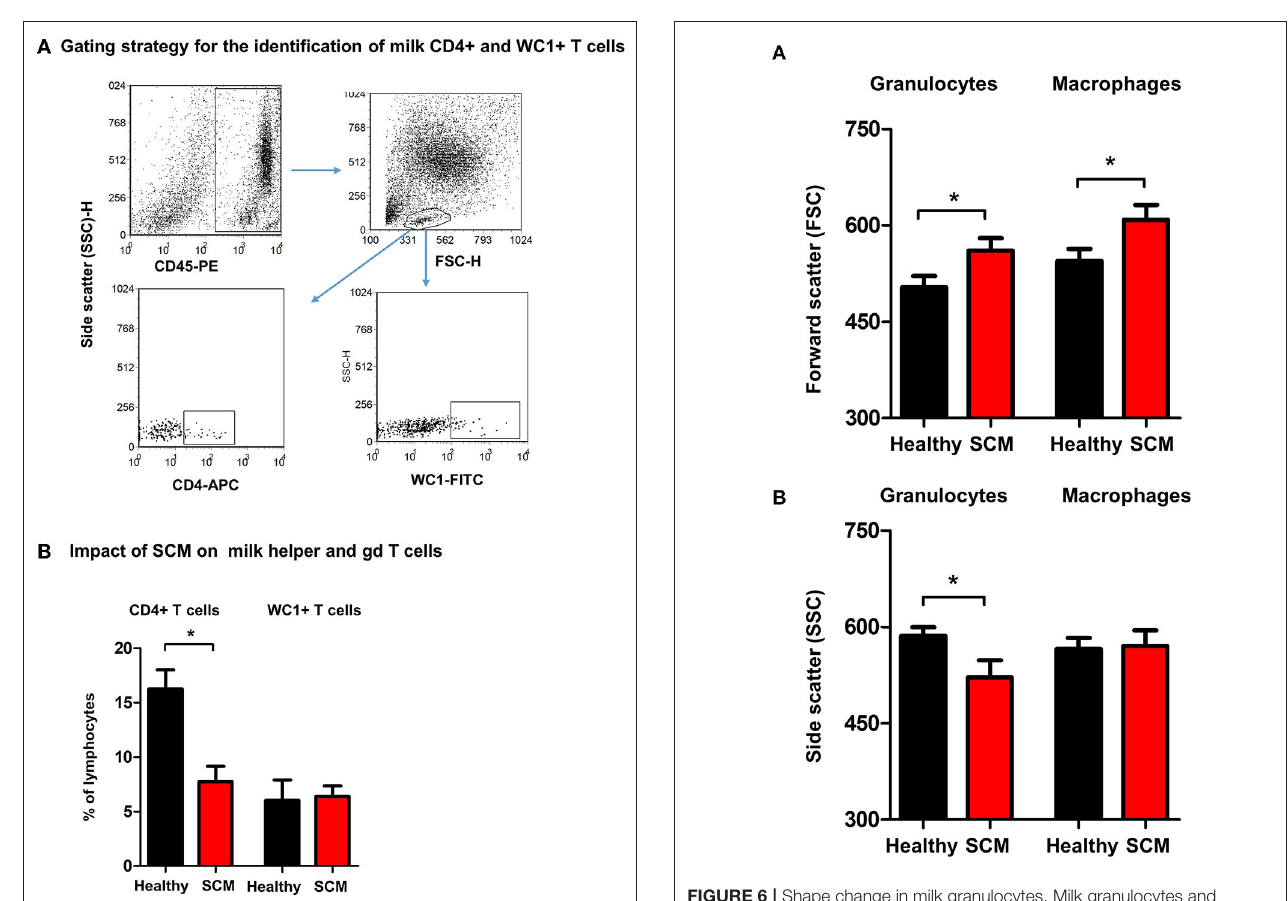
of peripheral blood granulocytes and monocytes, respectively,